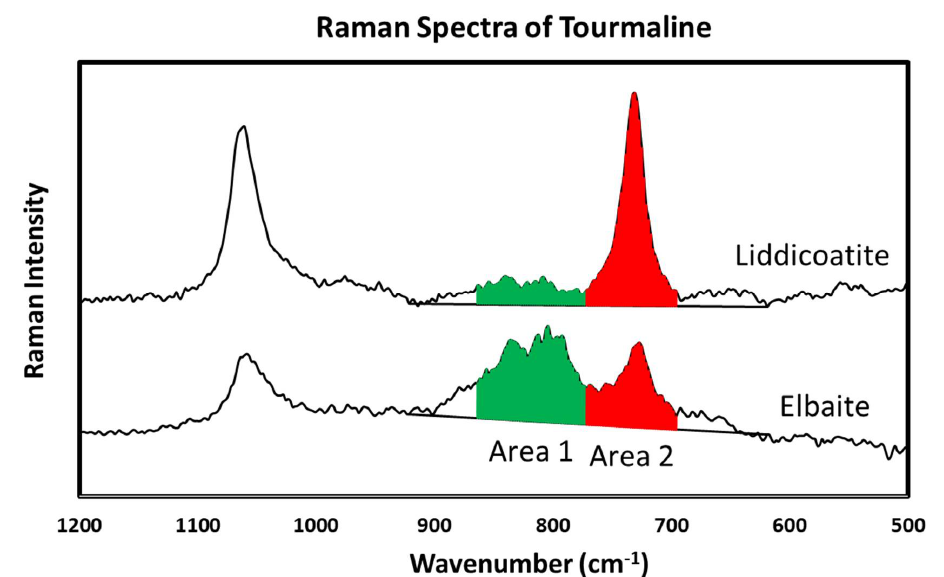
Figure 22. Raman spectra of two pixels in the Raman map. The bottom trace represents a pixel (pixel 1 in Figure 23) classified as elbaite while the top trace represents a pixel (pixel 2 in Figure 23) classified as liddicoatite. The ratio of the integrated green area 1 to the red area 2 can be plotted as the third parameter in the map to differentiate these two species. This allows higher resolution species